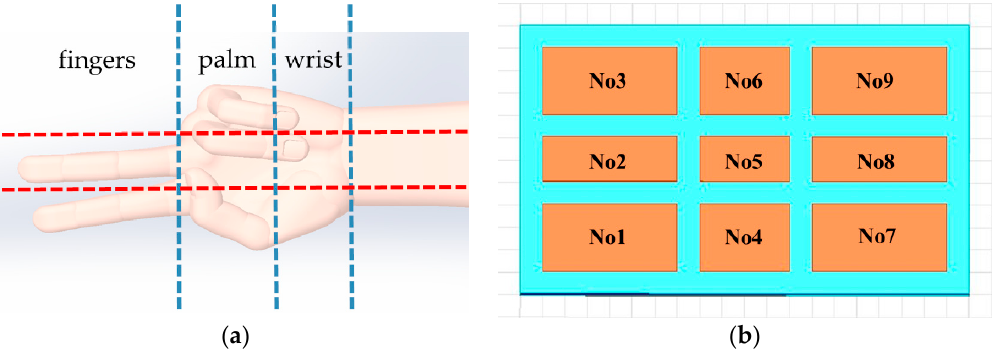
Figure 2. Electric-field detection system structure. 3D modeling software SolidWorks is used to establish different gesture models. All these models are imported into Maxwell, which is an electromagnetic field simulation software [26]. A total of four different gestures are drawn, including stretched hand, W-shaped gesture, V-shaped gesture, and fist, as shown in Figure 3. ( a ) ( d ) Figure 3. Gesture models: ( a ) stretched hand; ( b ) W-shaped gesture; ( c ) V-shaped gesture; ( d ) fist. According to the size of the ordinary human hand, the area of the sensing electrode of the detection system is determined to be 20 cm*12 cm, which is slightly larger than that of the hand. The hand can be divided into three areas: fingers, palm, and wrist. The fingers can be divided into three